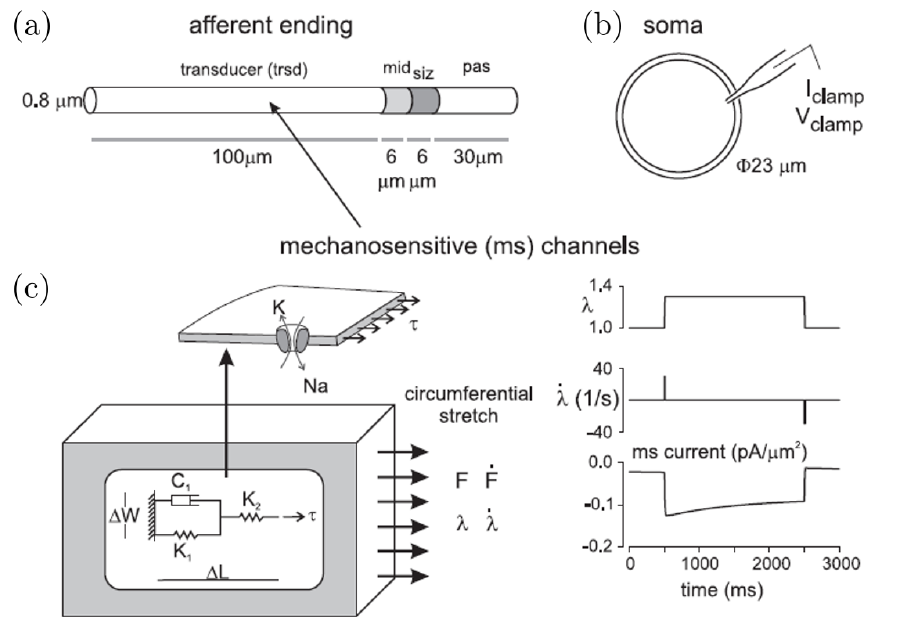
Figure 3. Schematic diagrams of our computational simulations of action potential generation in a mechanosensitive colorectal afferent endings. ( a ) We modeled the afferent ending as a four-segment cylinder consisting of a transducer zone (trsd), a spike initiation zone (siz), a transition zone in the middle (mid), and a passive conducting zone (pas). ( b ) We also included a representative mechanosensitive current in response to a stepped colorectal stretch at the afferent ending. ( c ) The afferent ending model simulates encoding of mechanical stretch by inclusion of mechanosensitive (ms) channels in the trsd zone gated by the membrane tension. We used a lumped parametric model to translate bulk colorectal deformation (force F, stretch ratio λ , and their first derivatives, ˙F, ˙ λ ) to the membrane tension at the afferent ending (adapted from